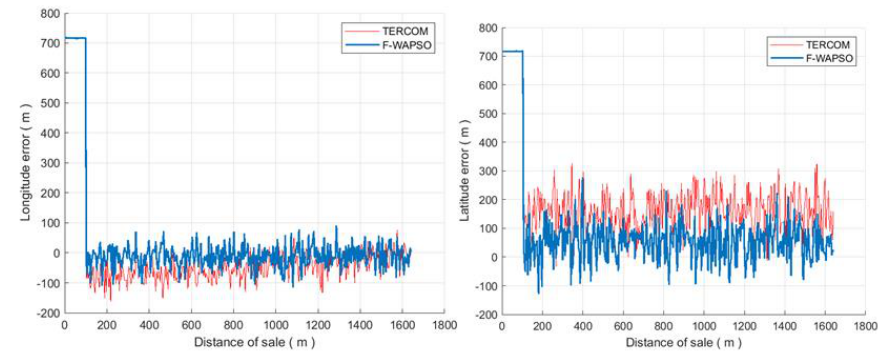
Figure 11. Longitude and latitude error curves of trajectory D.